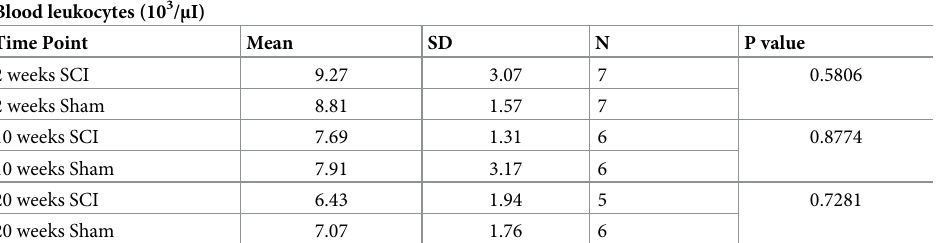
Table 1. Statistical results from comparisons between SCI and sham rats at 2, 10- and 20-weeks post-injury for differences in counts of total circulating leukocytes. Independent Student’s t-tests were performed to compare SCI and sham groups within each time point.